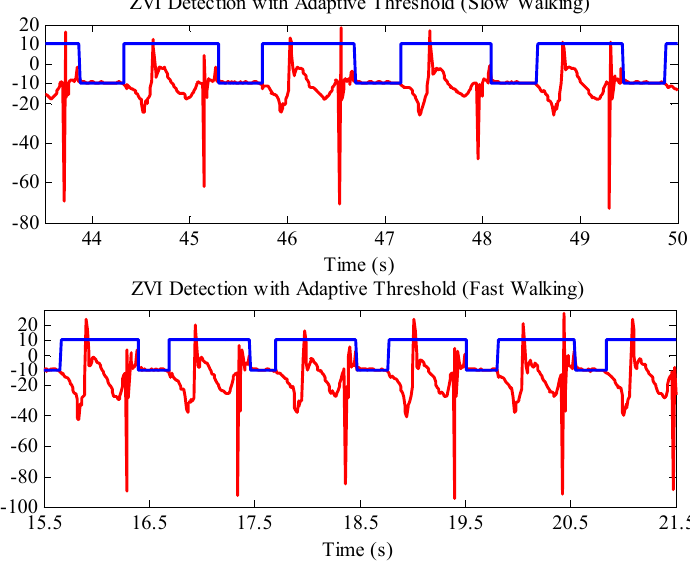
Figure 12. ZVI detection results with the adaptive ZVI detection algorithm at different walking speeds. The red lines are the z axis accelerometer outputs. The blue lines are the ZVI detection results; − 10 represents ZVI; and 10 indicates non-ZVI.